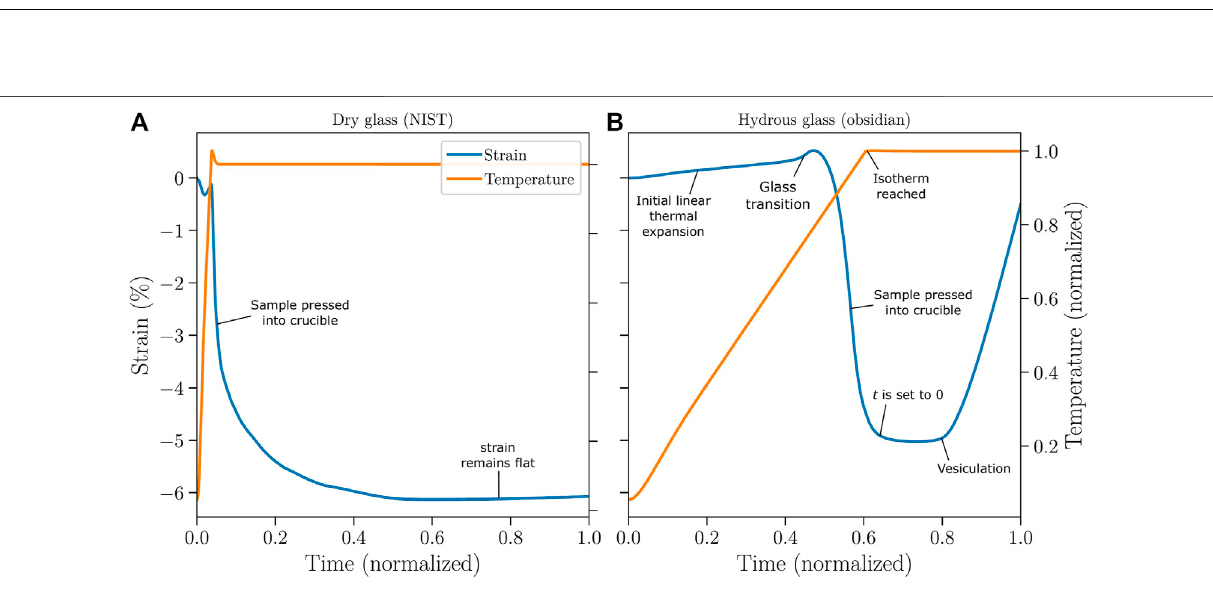
FIGURE3| Comparison ofstatic experiments using (A) standardborosilicatedry glassNIST SRM717a and (B) hydrousobsidian fromHrafntinnuhryggur, Iceland as starting material. After an initial phase ofcompressive strain (blueline) as the samples are pressed inside the crucible, strain then remains fl at inthe case of adry glass (A) but strain reverses in the case of a hydrous glass during the isotherm (B) indicating vesiculation. Temperature (orange line, normalized to target isothermal value, namely640 ° Cin (A) and965 ° Cin (B) )isalsoplotted.Time(sincethebeginningoftheexperiment)wasnormalizedtothetotalexperimenttime,namely9 hin (A) and 2 h in (B)